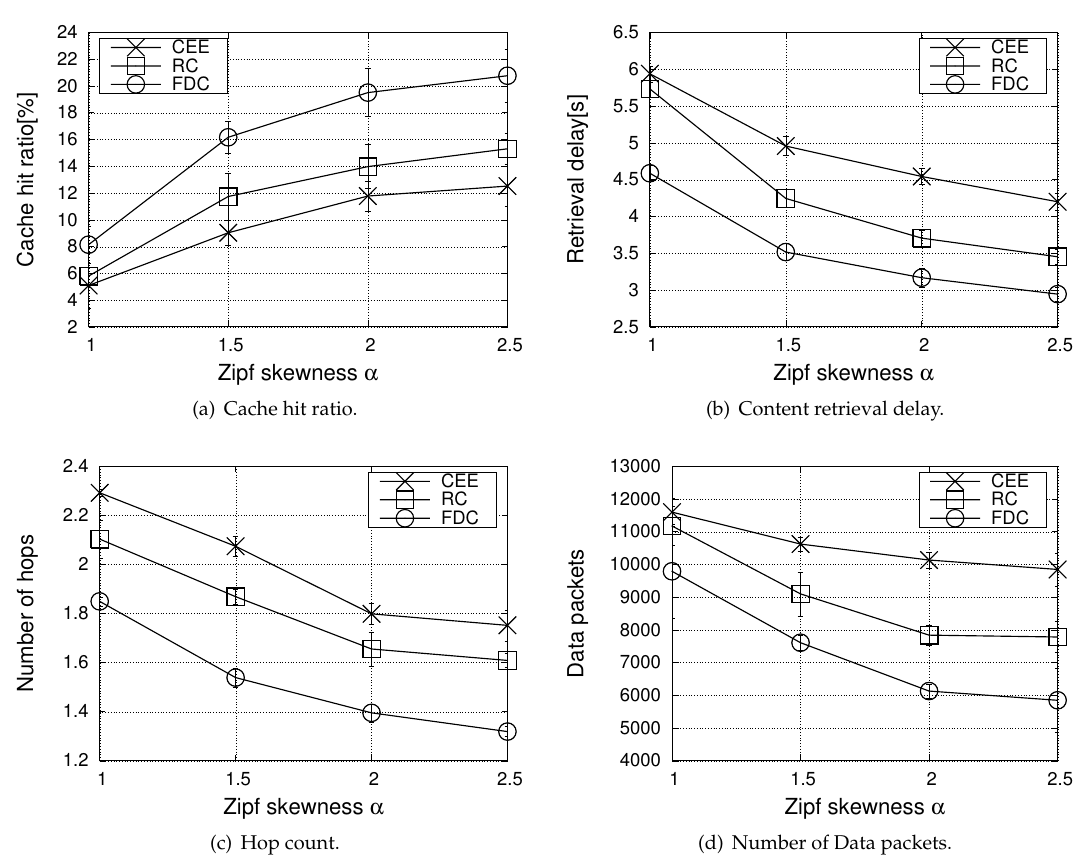
Figure 4. Performance metrics in the urban scenario, when varying the Zipf skewness parameter α (number of consumers equal to